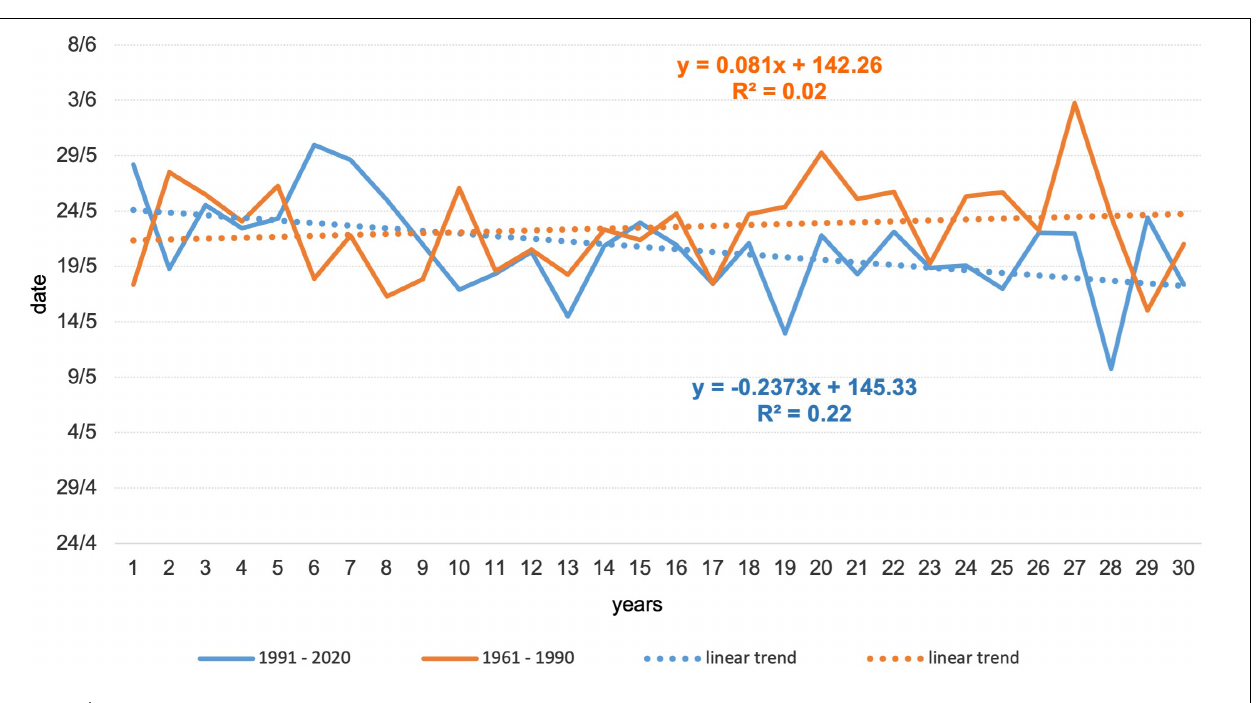
FIGURE 6 | Development and trends of Norway spruce flowering in the two periods.